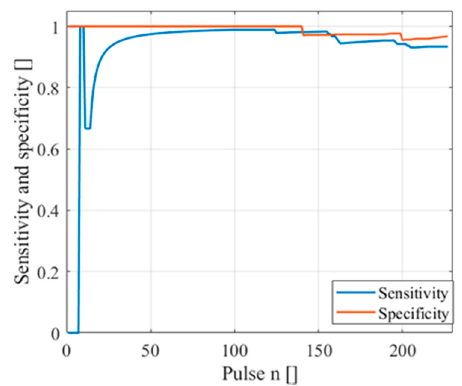
Figure 6. Sensitivity and specificity of the predictor in an experimental campaign.